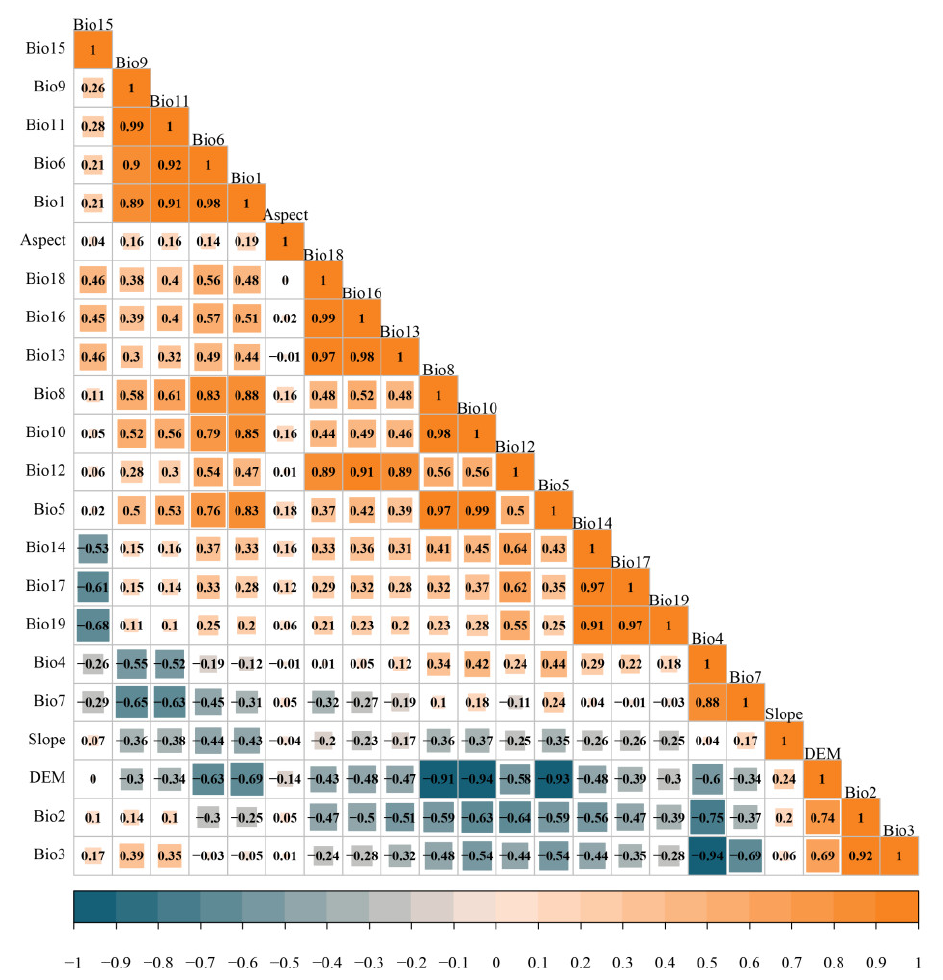
Figure 2. Correlation analysis of environmental variables.